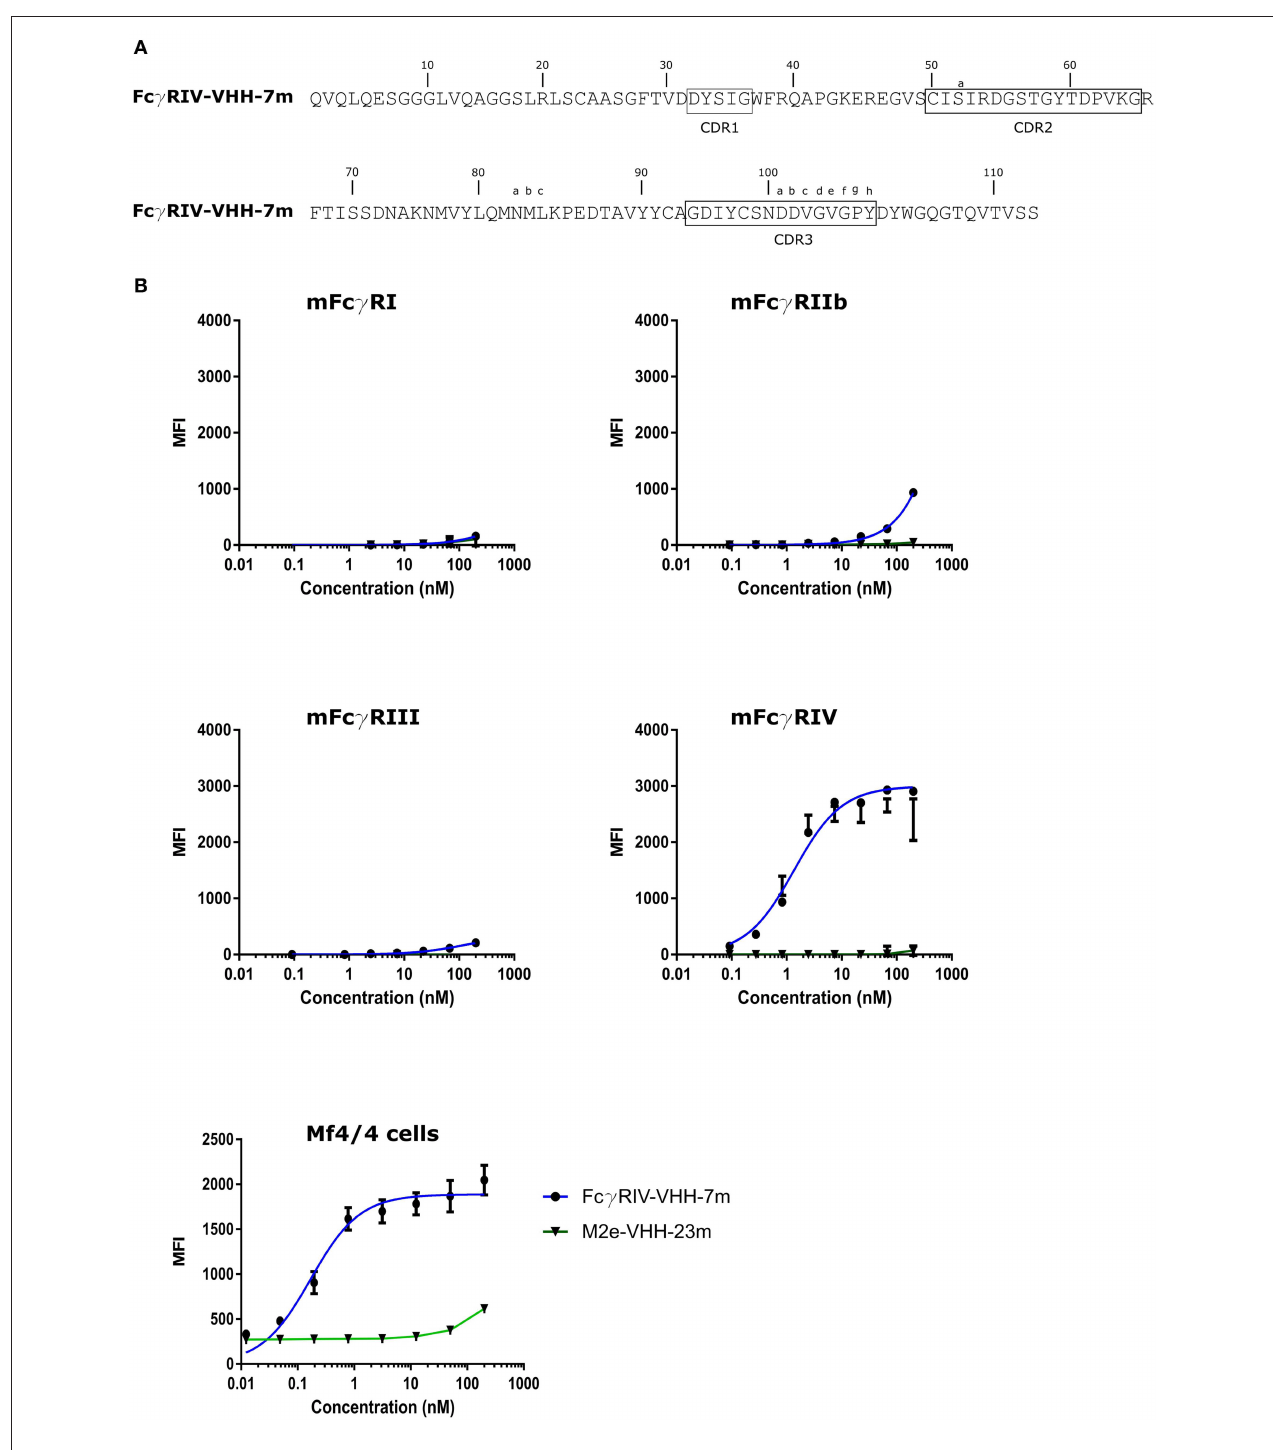
FIGURE 5 | Characterization of the isolated Fc γ RIV-specific VHH. (A) The predicted amino acid residue sequence of Fc γ RIV-VHH-7m, isolated after panning on recombinant mouse Fc γ RIV protein of a VHH library derived from a llama immunized with immature mouse dendritic cells. Above the sequences the Kabat numbering is indicated. CDR1, − 2, and − 3 are boxed. (B) Flow cytometric analysis showing binding of FcgRIV-VHH-7m and M2e-VHH-23m to HEK 293T cells transiently transfected with expression vectors coding for mouse Fc γ RI, F γ RIIb, Fc γ RIII, and Fc γ RIV along with the common γ -chain for the activating Fc γ Rs and a GFP expression plasmid. The lower graph depicts binding to Mf4/4 cells. The cells were incubated with fourfold serial dilution of Alexa Fluor TM 647 labeled Fc γ RIV-VHH-7m or M2e-VHH-23m, starting at a concentration of 0.2 µ M, binding of the VHHs to the GFP positive cells was analyzed. Data points represent averages of triplicates and error bars standard